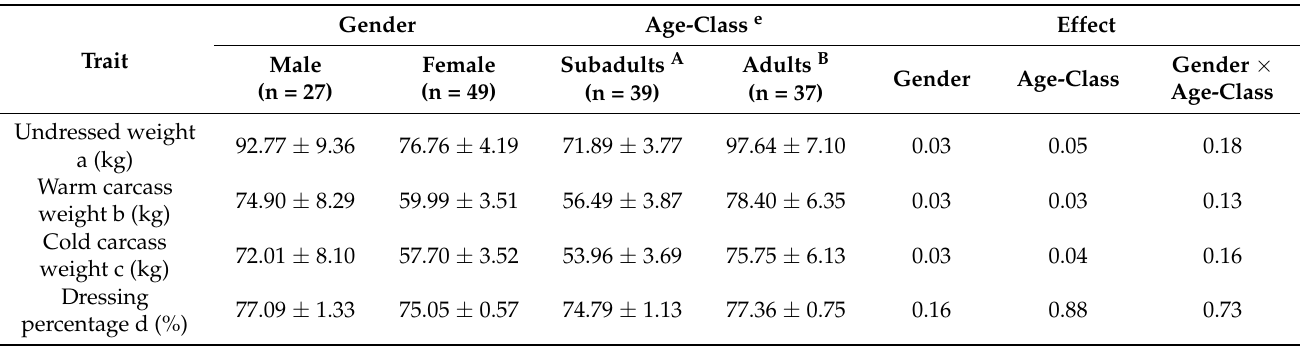
Table 2. Wild boar’s carcass distribution (mean ±